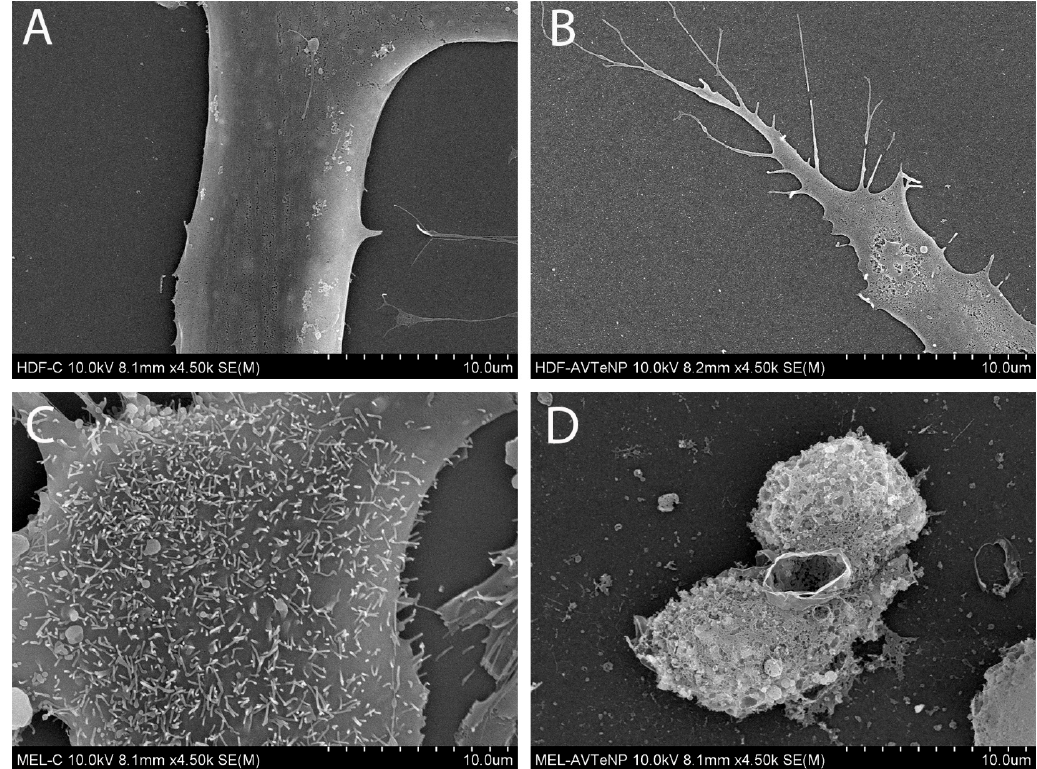
Figure A13. SEM micrographs of control human dermal fibroblast (HDF) and melanoma cells ( A , C , respectively) without and with AV-TeNP treatment ( B , D , respectively).